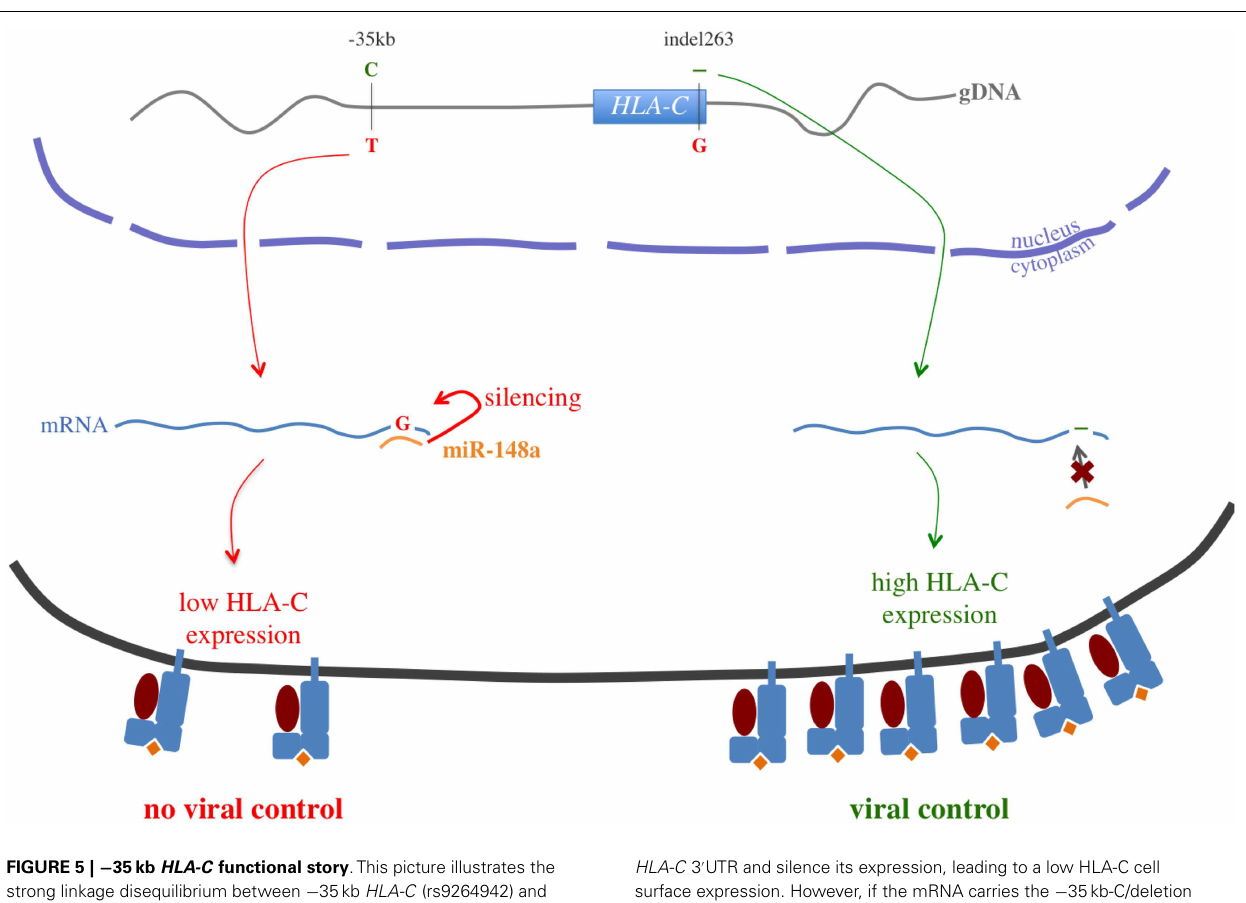
FIGURE 5 | − 35kb HLA-C functional story .This picture illustrates the strong linkage disequilibrium between − 35kb HLA-C (rs9264942) and the 3 (cid:48) UTR indel263 (rs67384697): the − 35kb-C allele is strongly correlated with the deletion, when the − 35kb-T allele is strongly correlated with the insertion of a G nucleotide. If the mRNA carries the − 35kb-T/insertion haplotype, the human miR-148a can bind to the